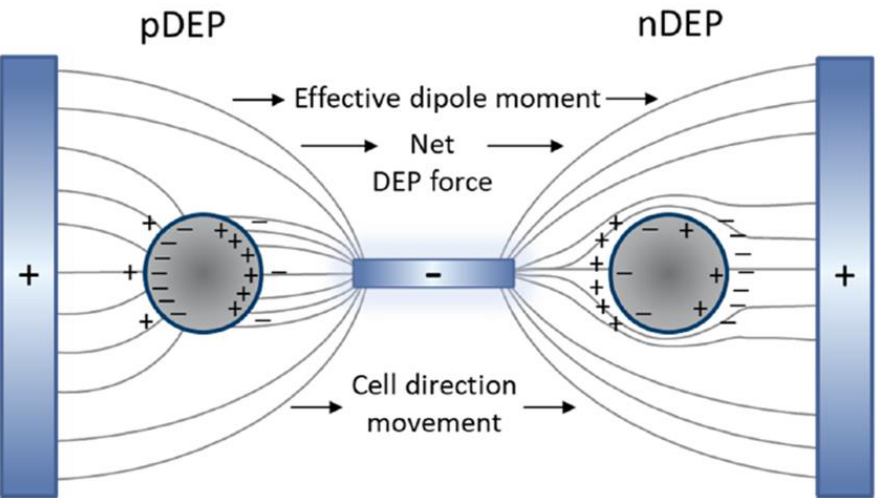
Figure 3. Induced dipole of the particle/cell and medium in the presence of a nonuniform electric field and generation of positive and negative dielectrophoresis (pDEP and nDEP, respectively) [15].